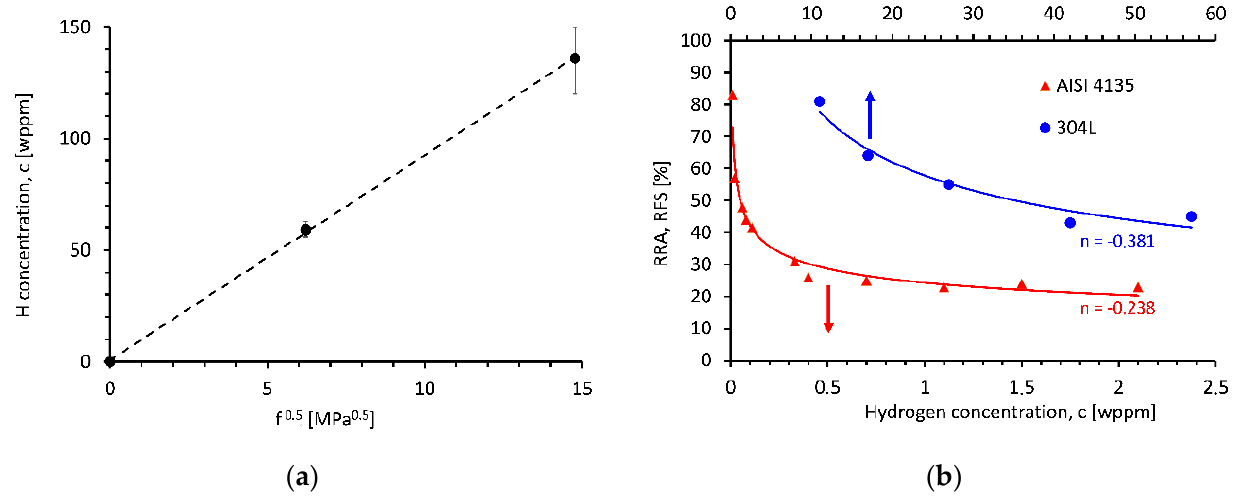
Figure 5. ( a ) Fugacity-modified Sievert’s law with data from [50,51], ( b ) RRA of 304L austenitic stainless steel [5] and relative fracture stress (RFS) of AISI 4135 martensitic high-strength steel [7] pre-charged with hydrogen as a function of hydrogen concentration.